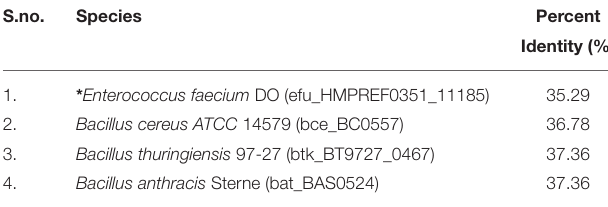
TABLE 1 | List of pathogens showing identity with Flotillin/Oligomerization domain of hsa_10211, Flotillin-1 of Homo sapiens (taken as reference). S.no.